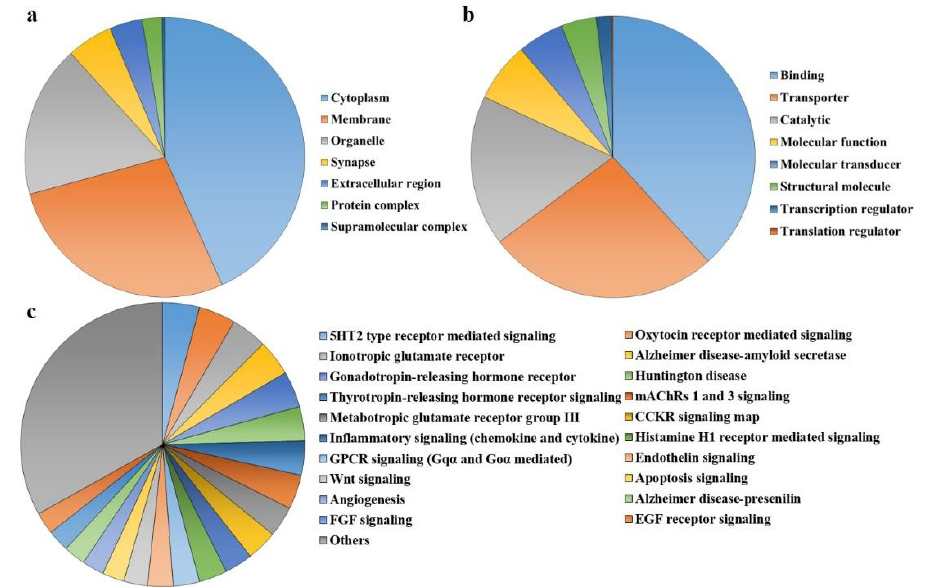
Figure 2. Protein ANalysis THrough Evolutionary Relationships (PANTHER) Gene Ontology (GO) annotation analysis [42]: The distribution of GO terms was categorized based on PANTHER GO-Slim. ( a ) The Cellular Component GO terms (components of cells or extracellular) with 393 component hits, ( b ) the Molecular Function GO terms (basic activities of a gene product at the molecular level, such as binding or catalysis) with 473 function hits, and ( c ) the Molecular Pathway GO terms (collection of molecular events or operation, with a strict definition of the beginning and end) with 592 pathway hits (429 genes in each annotation).